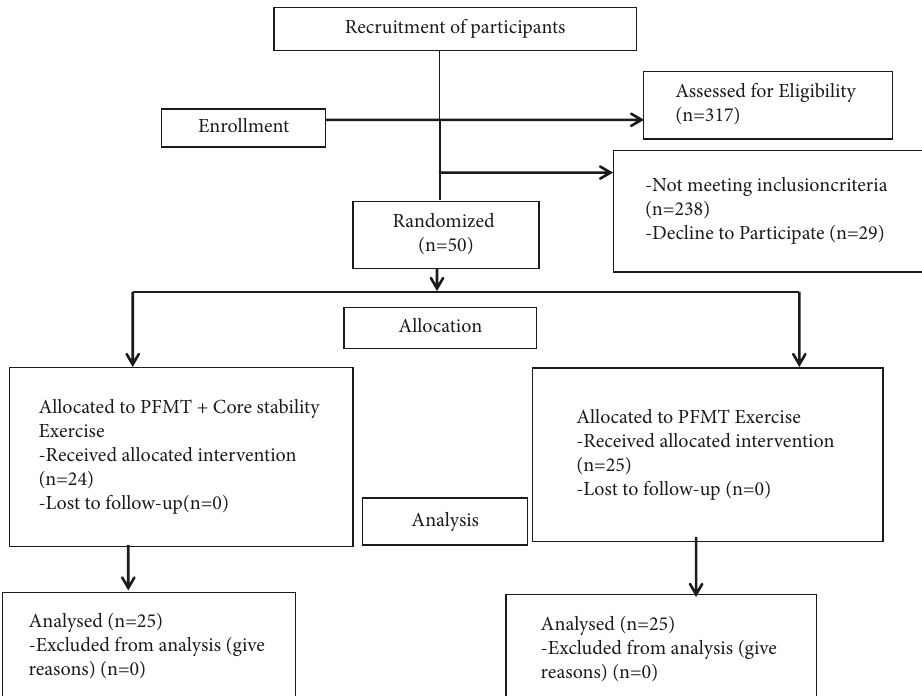
Figure 1: Consolidated Standards of Reporting Trials (CONSORT) flow